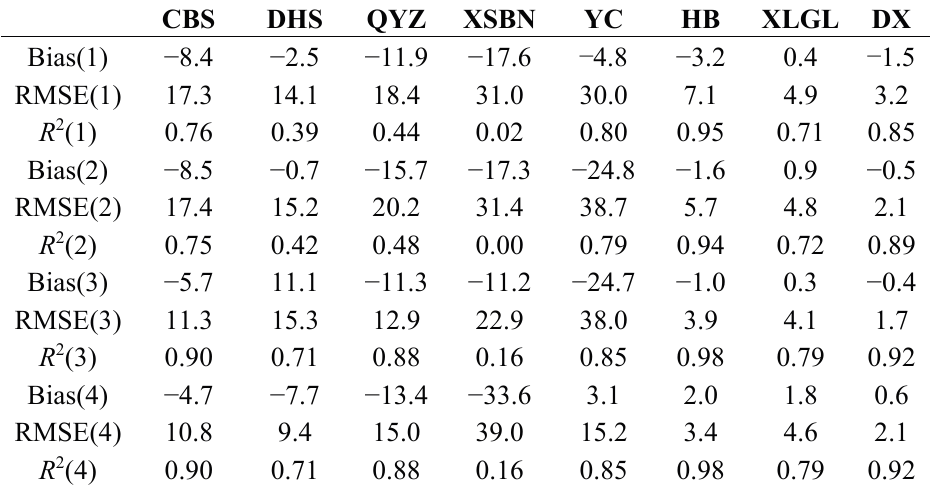
Table 2. Comparison between the flux derived GPP and (1) the original MODIS-GPP products; (2) using in-site meteorology data, MOD17 maximum light use efficiency and MODIS-FPAR to estimate GPP (GPP_MOD); (3) using in-site meteorology data, MOD17 maximum light use efficiency and GLASS-FPAR to estimate GPP (GPP_GLA); and (4) using in-site meteorology data, optimized maximum light use efficiency and GLASS-FPAR to estimate GPP (GPP_GLA2) for each site, respectively. Where, CBS in mixed forests site; DHS and XSBN in evergreen broadleaf forests site; QYZ in evergreen needleleaf forests site; YC in croplands; HB, XLGL and DX in grasslands